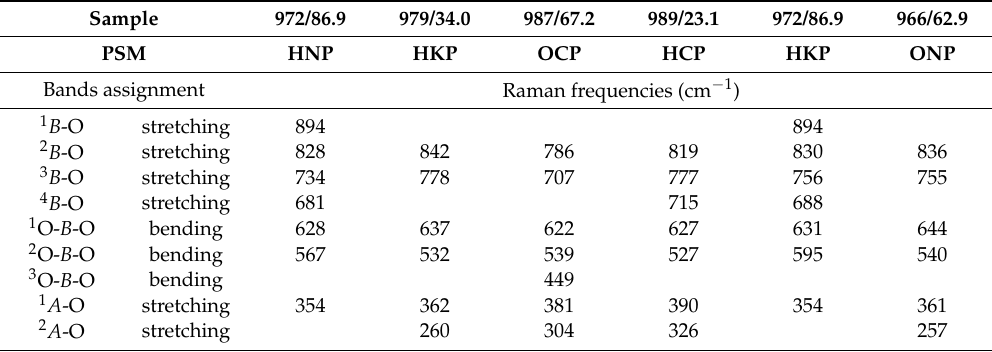
Table 9. The PSM chemical composition, Raman shifts and their